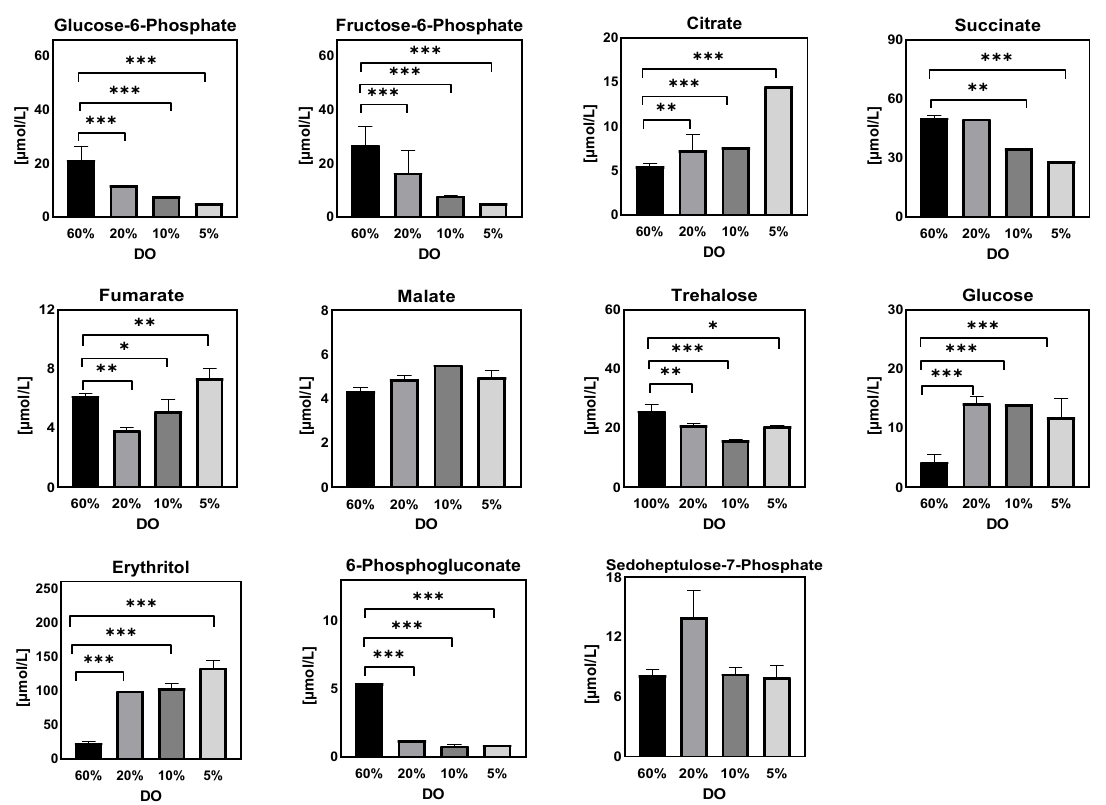
Figure 7. Extracellular concentrations of sugar phosphates, organic acids, and sugar alcohols in Penicillium chrysogenum Wisconsin 54-1255 under steady-state dissolved oxygen (60%, 20%, 10%, and 5%) conditions. Samples were collected at 24 h intervals and data were collected from three replicate experiments; Two-tailed Student’s t -tests ((*) p < 0.05, (**) p < 0.01 and (***) p < 0.001) were performed using GraphPad Prism